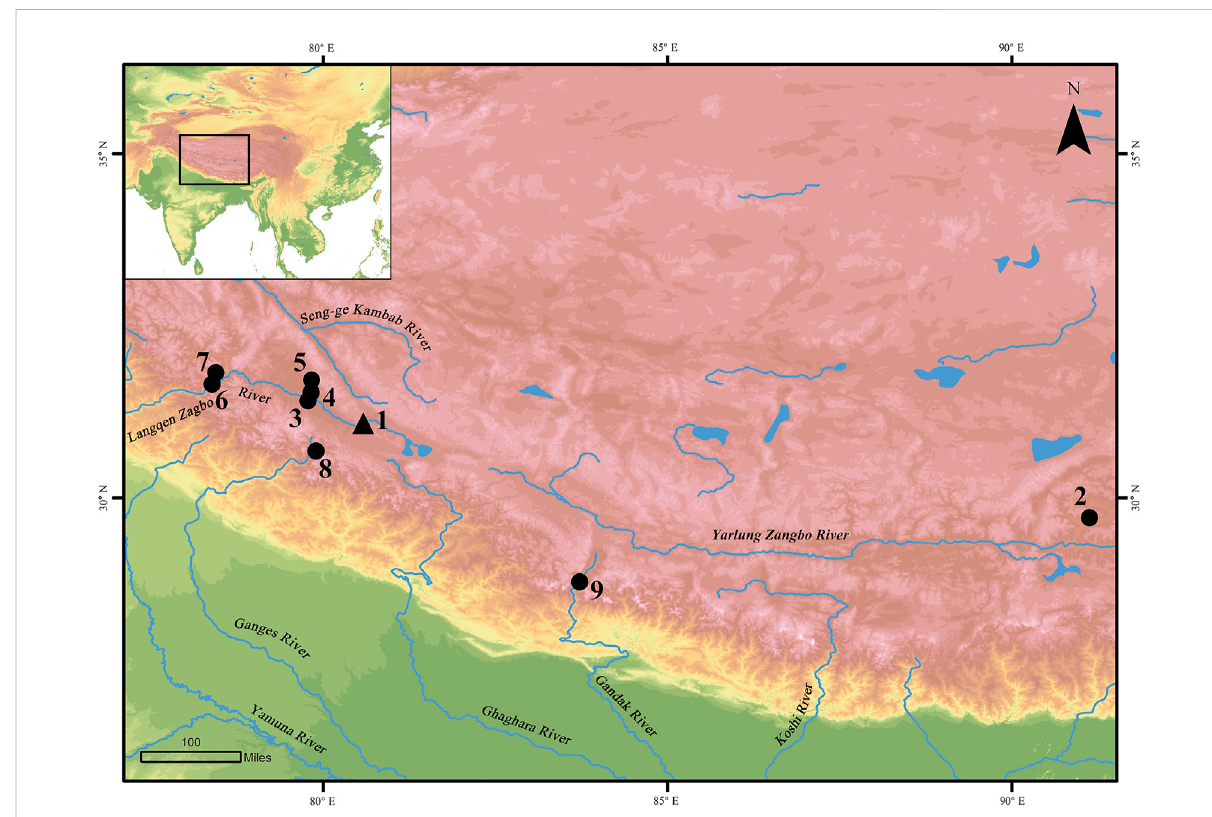
FIGURE 5 Location of the sites mentioned in the article. 1. Qulong; 2. Qugong; 3. Chuvthag; 4. Gepa Serul; 5. Gelingtang; 6. Lippa; 7. Ropa; 8. Malari; 9.